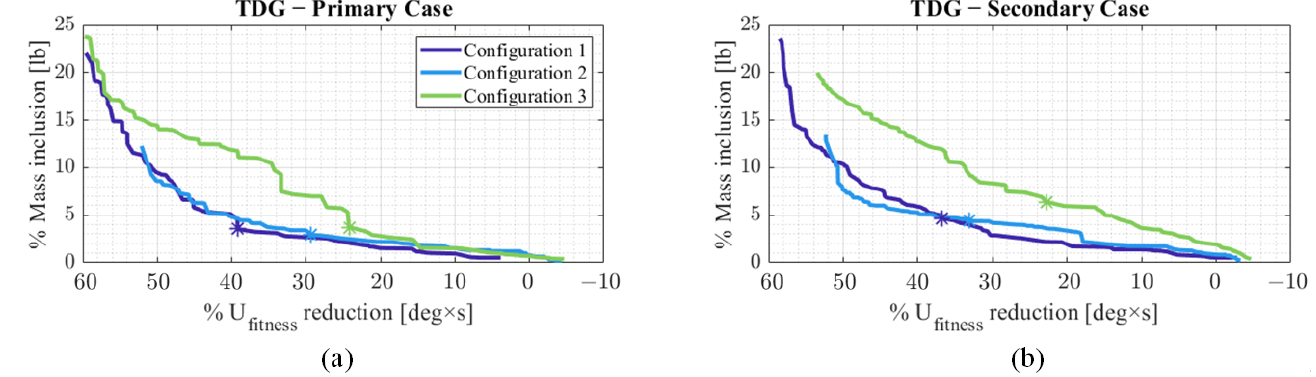
Figure 13. Comparison of Pareto fronts between all configurations investigated in the study for both the ( a ) primary and ( b ) secondary operational scenarios modelled with the TDG. Table 5. Pareto front values for the best individuals under the TDG gust excitation model.